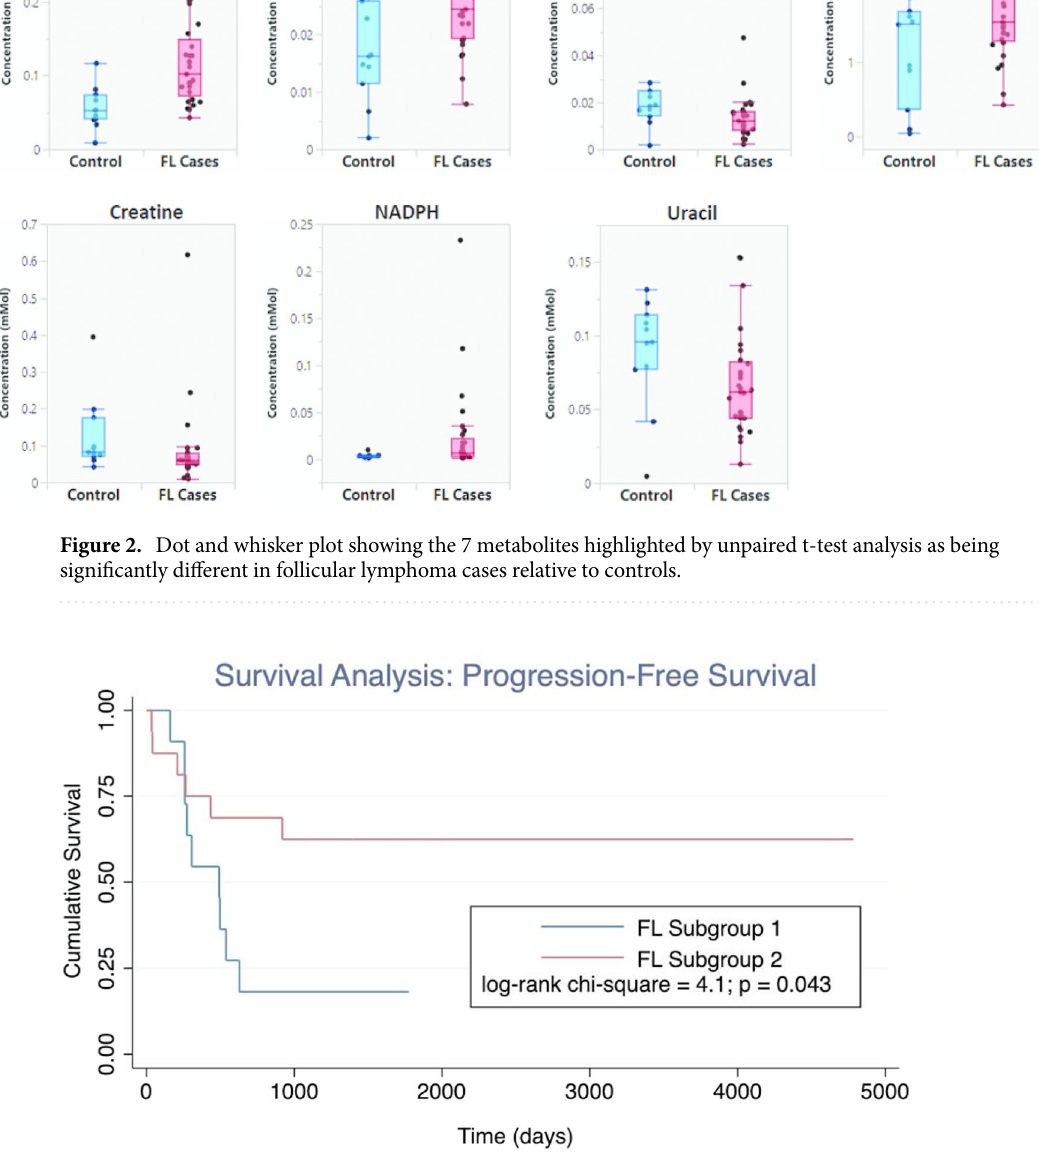
Figure 3. Kaplan–Meier analysis demonstrating significantly different progression-free survival by metabolomic